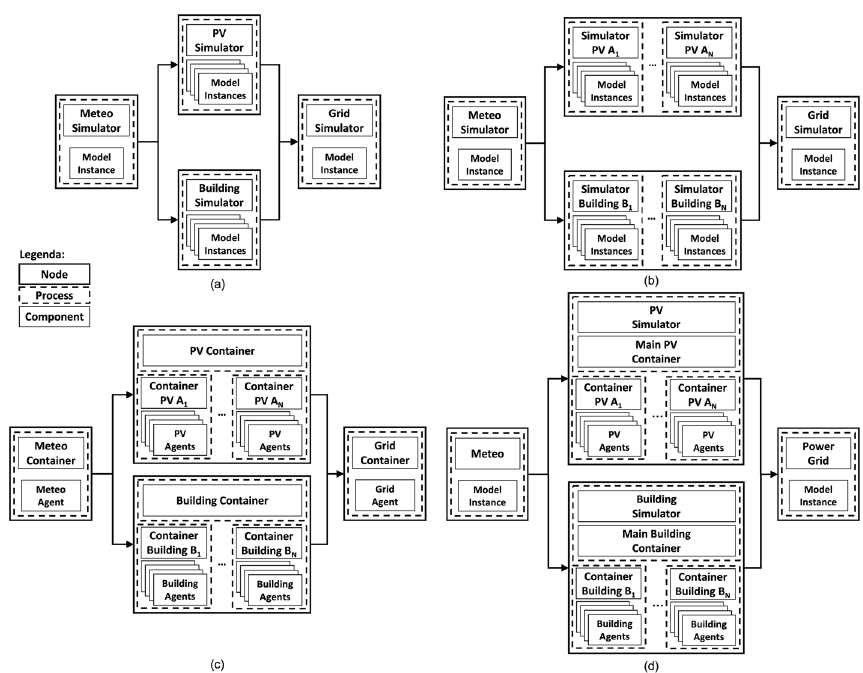
Fig. 7 Different implementations of the co-simulation framework benchmark configurations: ( a ) Classic Co-simulation, ( b ) Multi-process co-simulation, ( c ) MAS as co-simulation, and ( d ) Classic Co-simulation with encapsulated